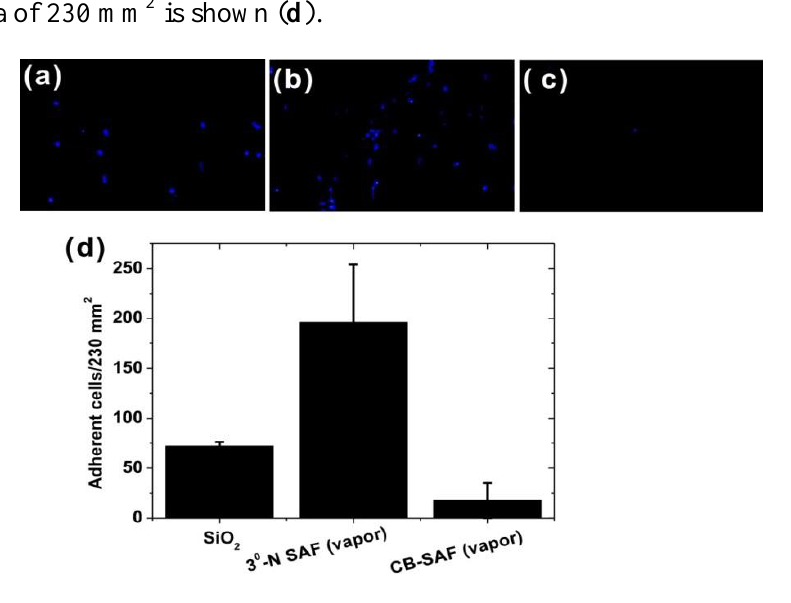
Figure 5. Fluorescence images of adherent blood cells on ( a ) glass; ( b ) 3°-N SAF (vapor); and ( c ) CB SAF (vapor) substrates. The blood samples were flowed in the microfluidic system with chaotic mixer to increase the contact probability of cells to surfaces. After buffer washing, the adherent cells were stained with fluorescent probes and determined using a fluorescence microscope. The quantitative estimation of adherent cell numbers on an image area of 230 mm 2 is shown ( d